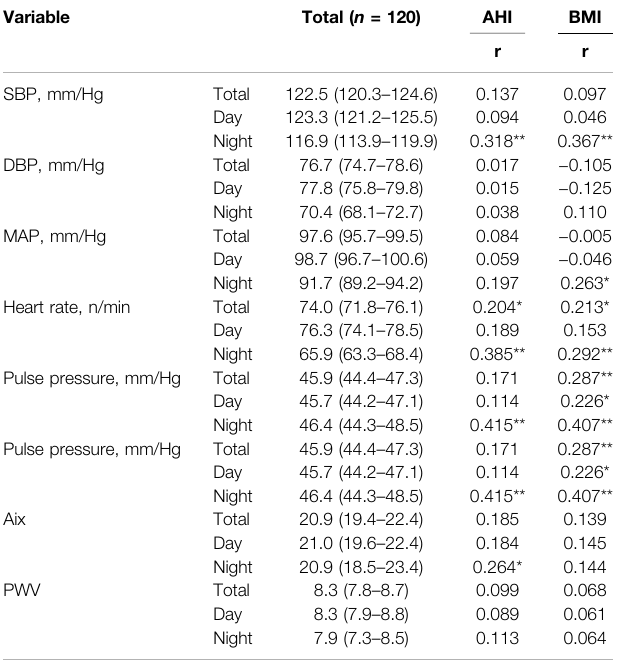
TABLE 4 | 24-h blood pressure monitoring parameters of the study population and their correlation with AHI and BMI.